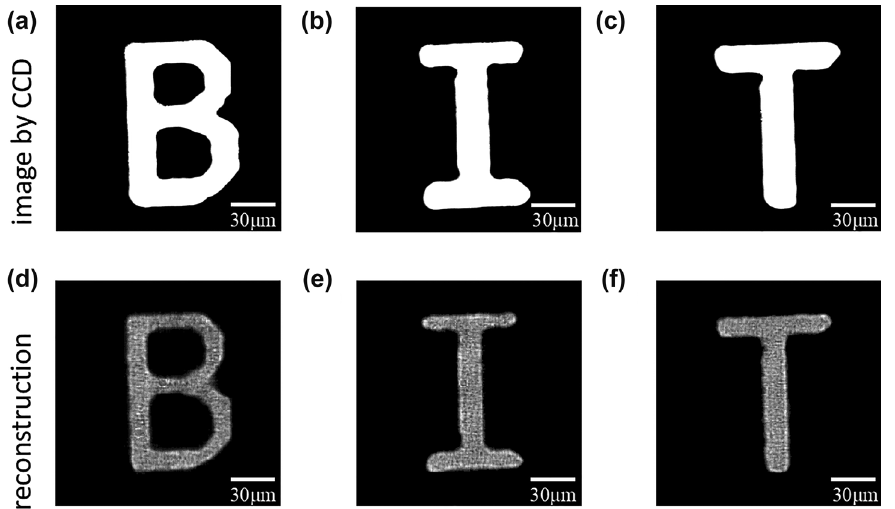
Figure 6: The experimental results of our sample. (a–c) ‘‘B’’, ‘‘I’’ and ‘‘T’’ letters directly obtained by CCD camera, respectively. (d–f) The reconstruction of ‘‘B’’, ‘‘I’’ and ‘‘T’’ letters by using SPI scheme, respectively. Scale bars, 30 μ m. Pixel resolution, 500 nm. Pixel numbers, 300 ×